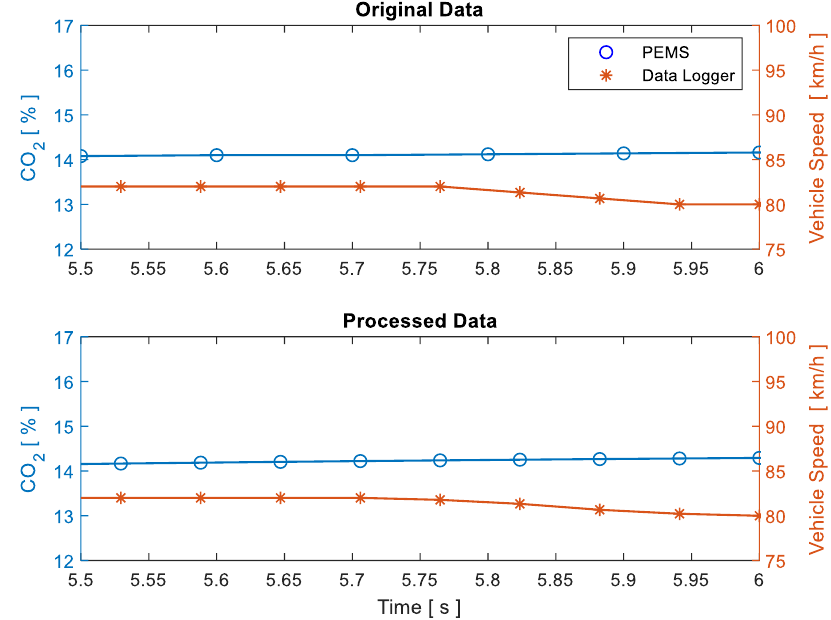
Figure 2. Signal processing from PEMS and data logger.